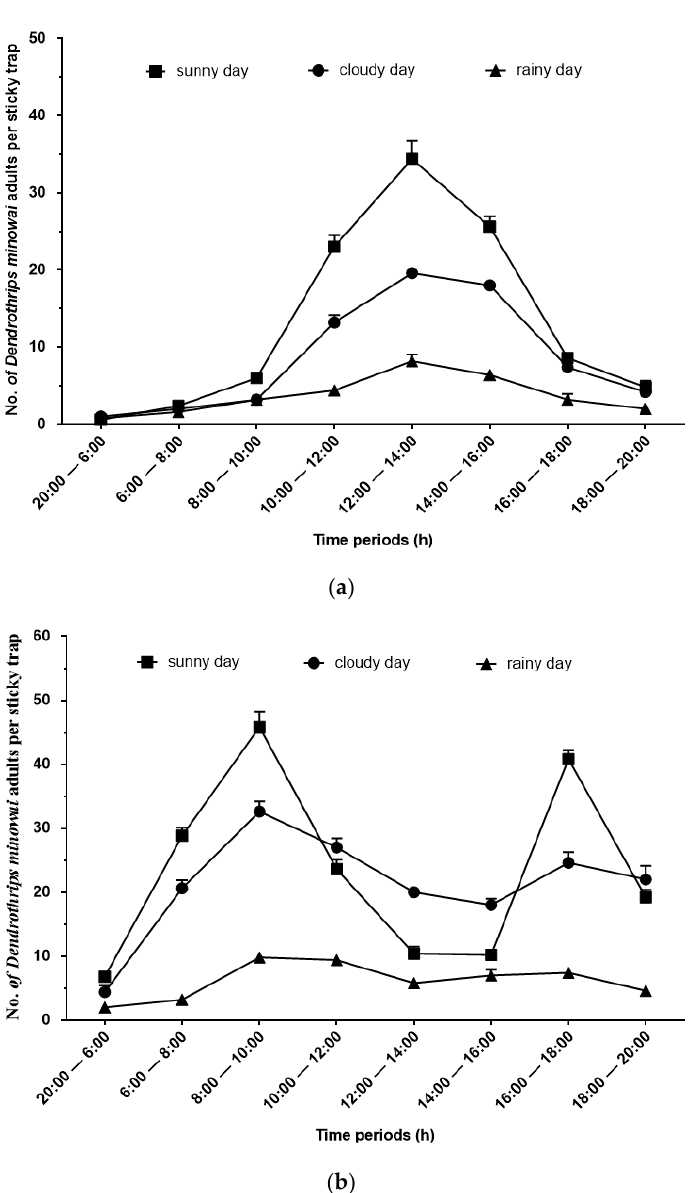
Figure 3. Numbers (mean ± SEM) of D. minowai adults captured in traps in different periods under different weather conditions. ( a ): Shaoxing in April 2022; ( b ): Shaoxing in June 2022. Five blue sticky traps were placed in the sampling area during each sampling period.